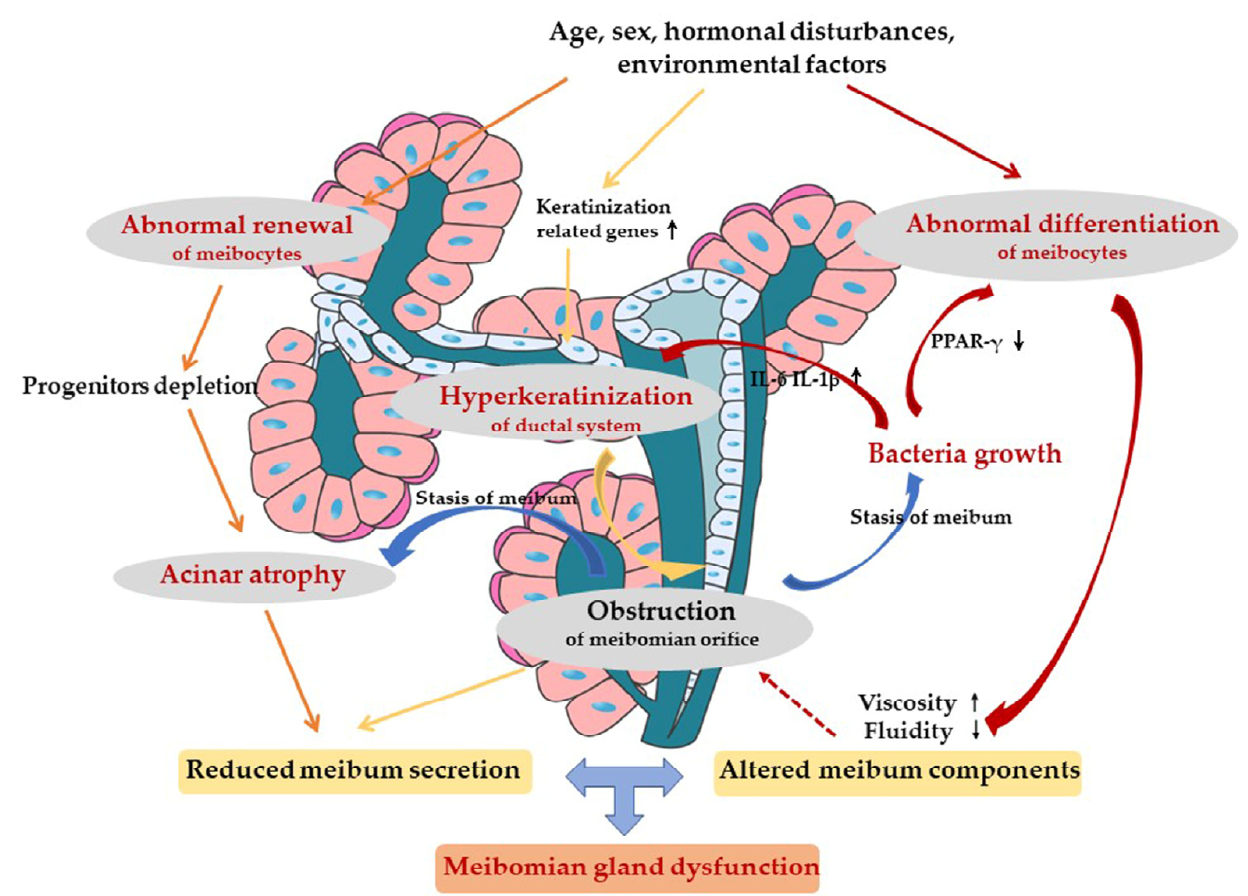
Figure 4. Pathogenesis of MGD occurs as a result of hyperkeratinization of the ductal system